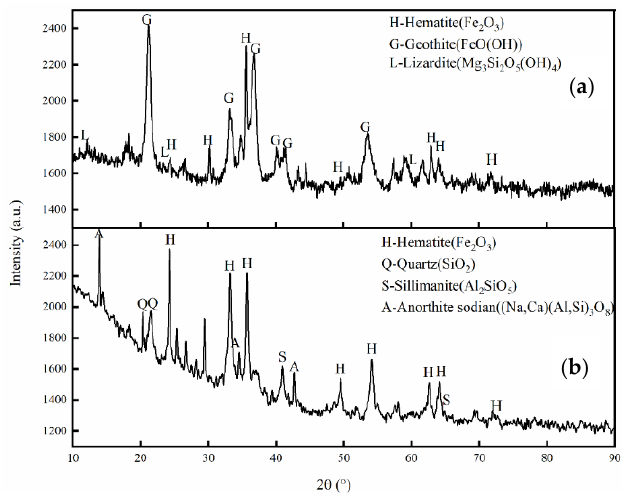
Figure 1. XRD patterns of raw materials: ( a ) nickel laterite ore; ( b ) red mud. The reductant was anthracite with a particle size of less than 1 mm, in which the fixed carbon was 63.90 wt%, ash was 23.25 wt%, the volatile matter was 11.69 wt%, and moisture was 1.17 wt%.